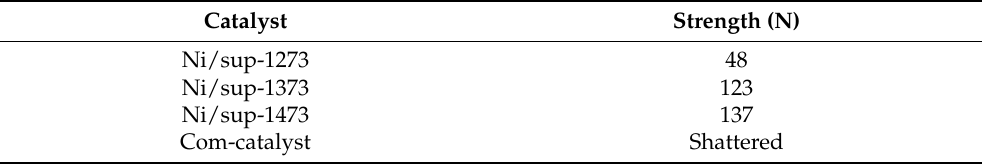
Table 2. Strength of the catalysts